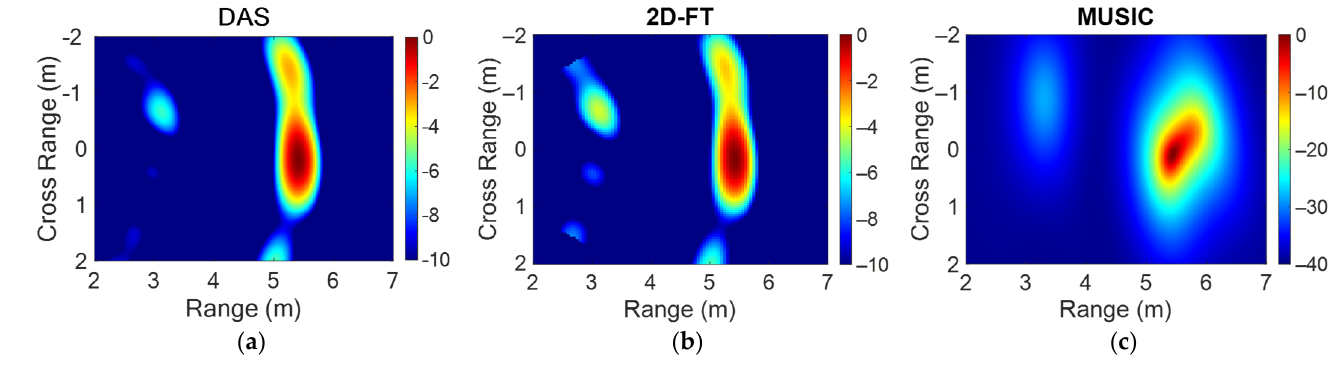
Figure 21. Map of the normalized intensity function in the ROI for the scenario in Figure 20 obtained with DAS ( a ), 2D-FT ( b ), and MUSIC ( c ) algorithms.